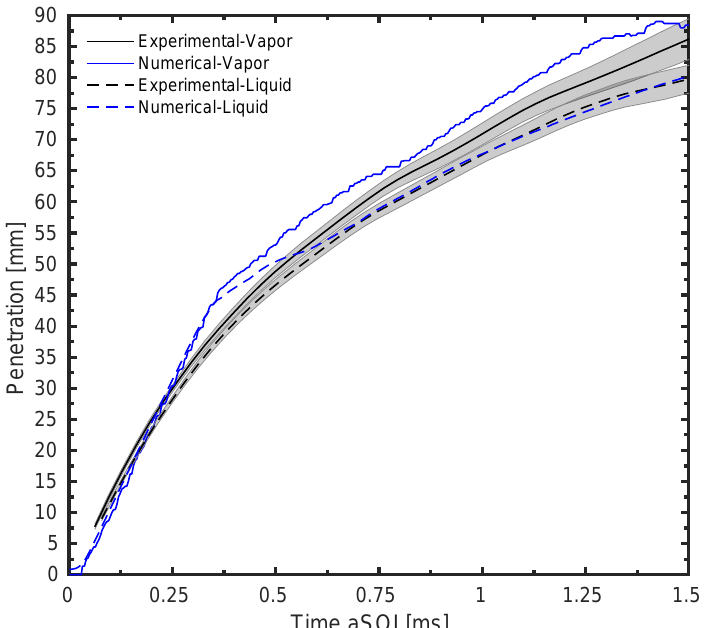
Figure 10. Numerical and experimental axial vapor and liquid phases penetration for the G2 cold condition for